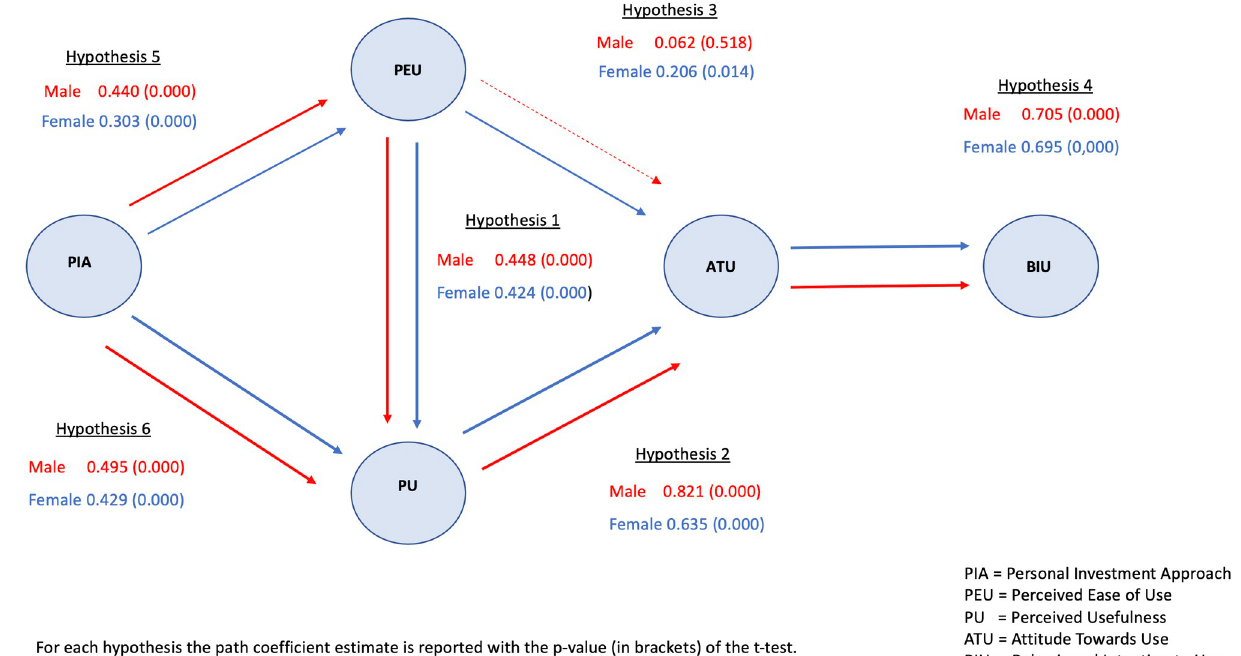
Fig 3. Technology acceptance constructs and causality links segmented by